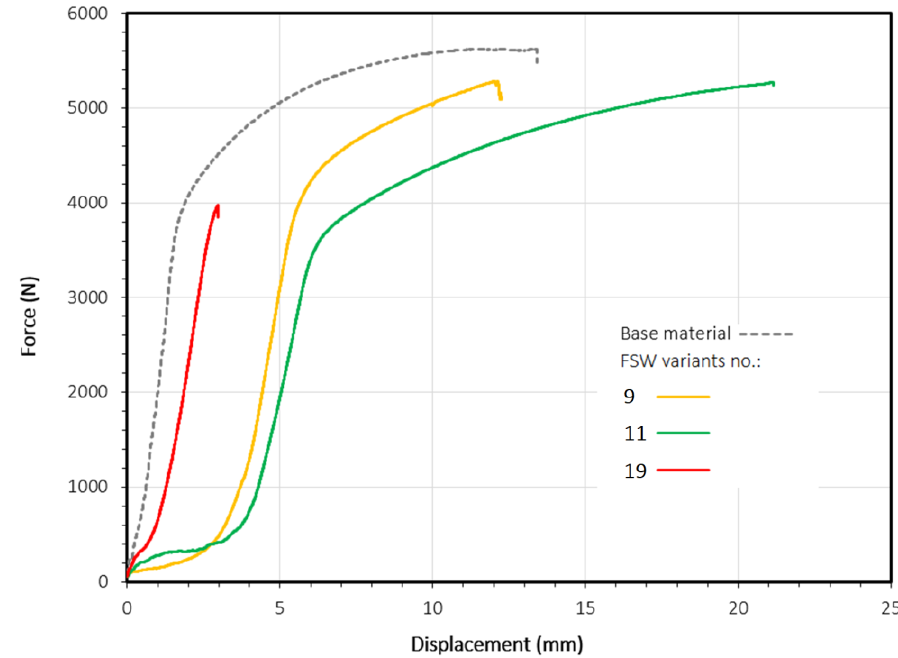
Figure 6. Force–displacement curves determined in the tensile/pure shear tests for FSW variants no. 9, 11, and 19.